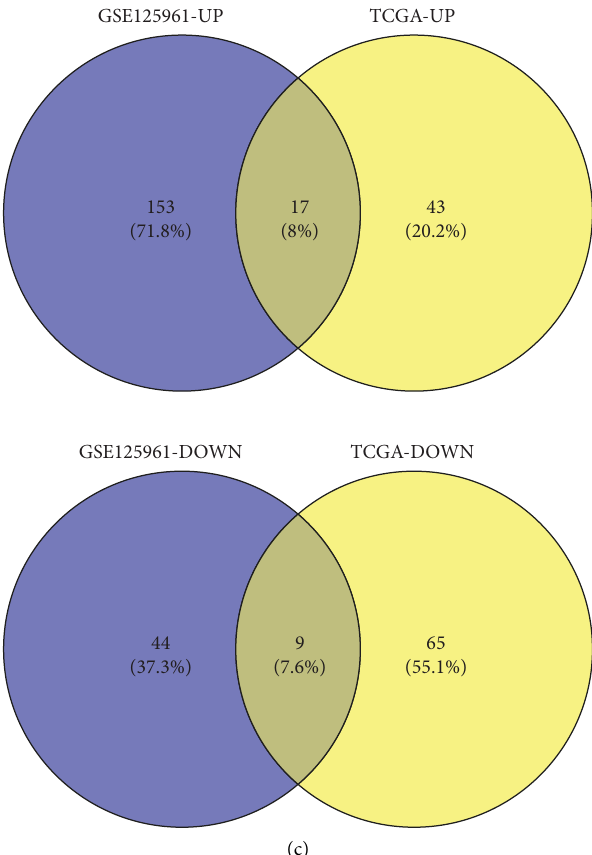
Figure 2: DEmiRNA screening and miRNA-target gene regulatory network. Heatmap of DEmiRNAs in the GEO (a) and TCGA datasets (b). Te orange bar represents the normal group, and the yellow bar represents the tumor group. (c) Te overlapped up and downregulated miRNAs screened from the GEO and TCGA datasets. DEmiRNA, diferentially expressed microRNA; GEO, Gene Expression Omnibus; TCGA, the Cancer Genome